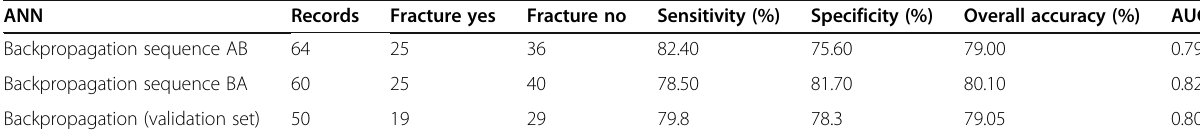
Table 3 Predictivity results obtained with tripartite subdivision of the dataset. The first two subsets with 124 records were used for training-testing experiments ( n = 64 and n = 60, respectively), while the third subset with 50 records was employed for